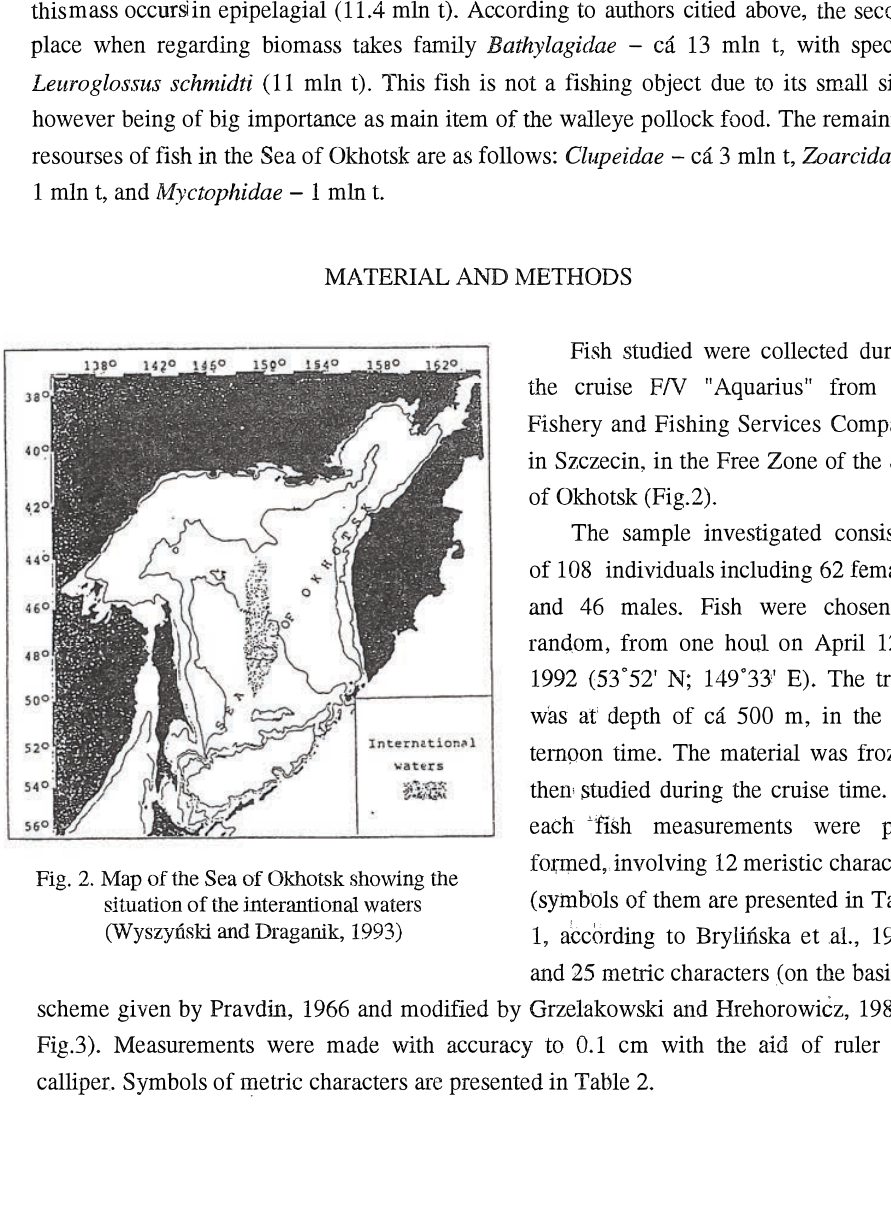
Fig. 2. Map of the Sea of Okhotsk showing the situation of the interantional